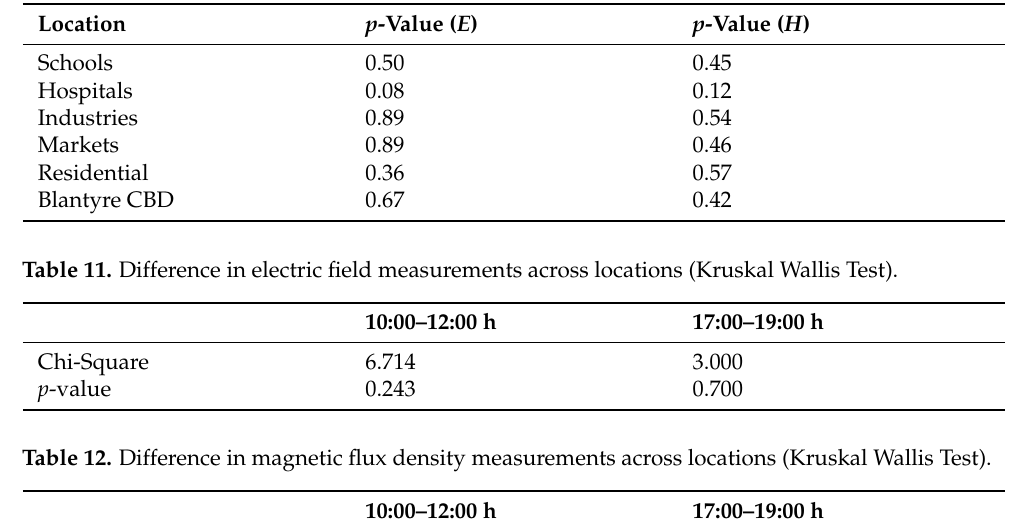
Table 10. Difference in measurements within locations (Wilcoxon Signed Rank Test).